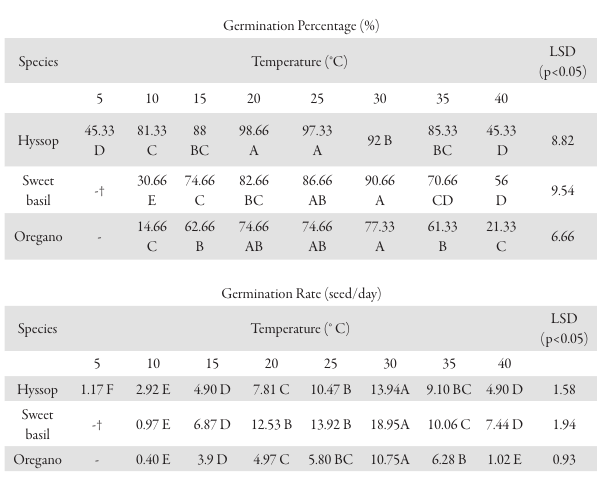
Tab. 1. Temperature effects on seed germination percentage (%) and germination rate of Hyssop, Sweet basil and